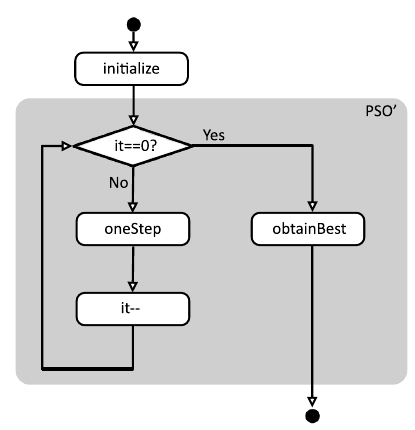
Figure 1. Basic flowchart of function pso